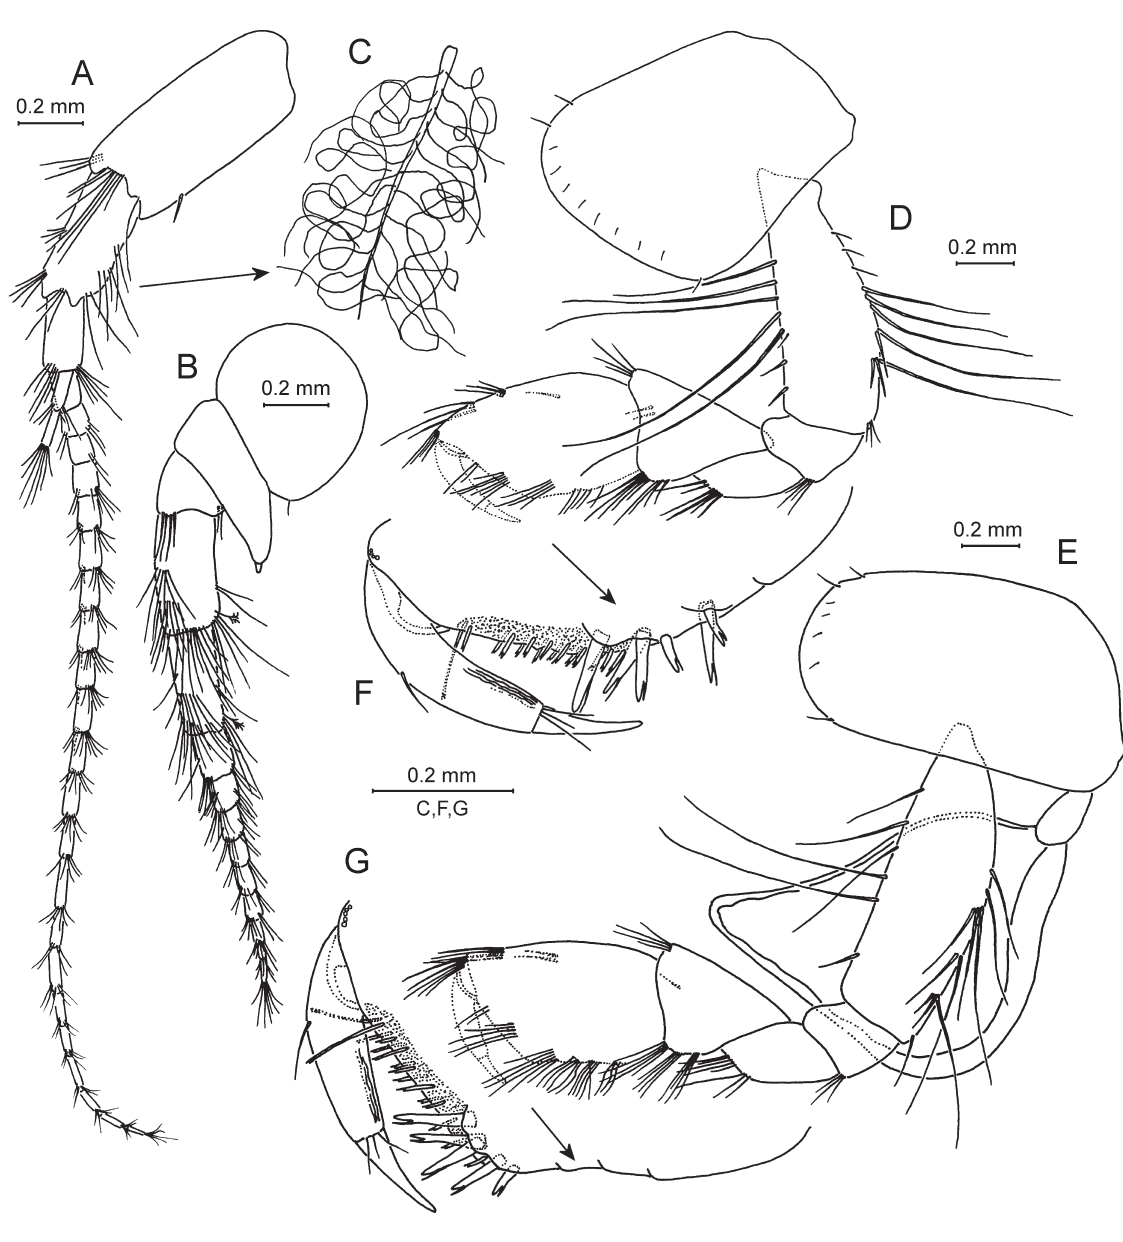
Fig. 7. Zenkevitchia sandroruffoi sp. nov. Holotype, ♂, 8.0 mm, X44041/Cr-1647-FEFU. A . Antenna 1. B . Antenna 2. C . Barbate seta with attached filamentous algae. D . Gnathopod 1. E . Gnathopod 2. F–G . Palmar margins of gnathopods 1 and 2